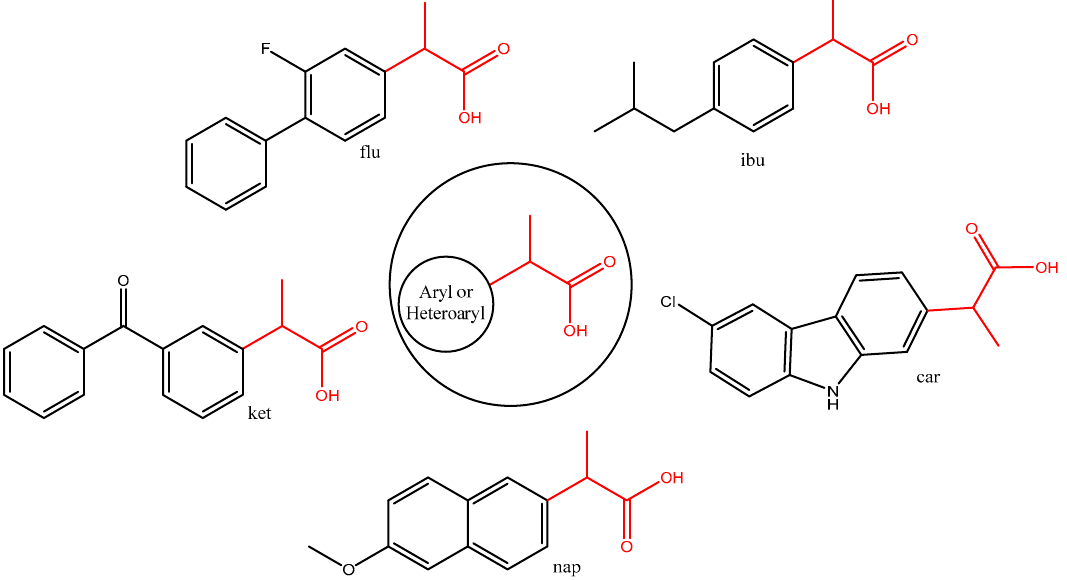
Figure 2. Structural formulas of Ibuprofen (ibu), flurbiprofen (flu), ketoprofen (ket), naproxen (nap), and carprofen (car).